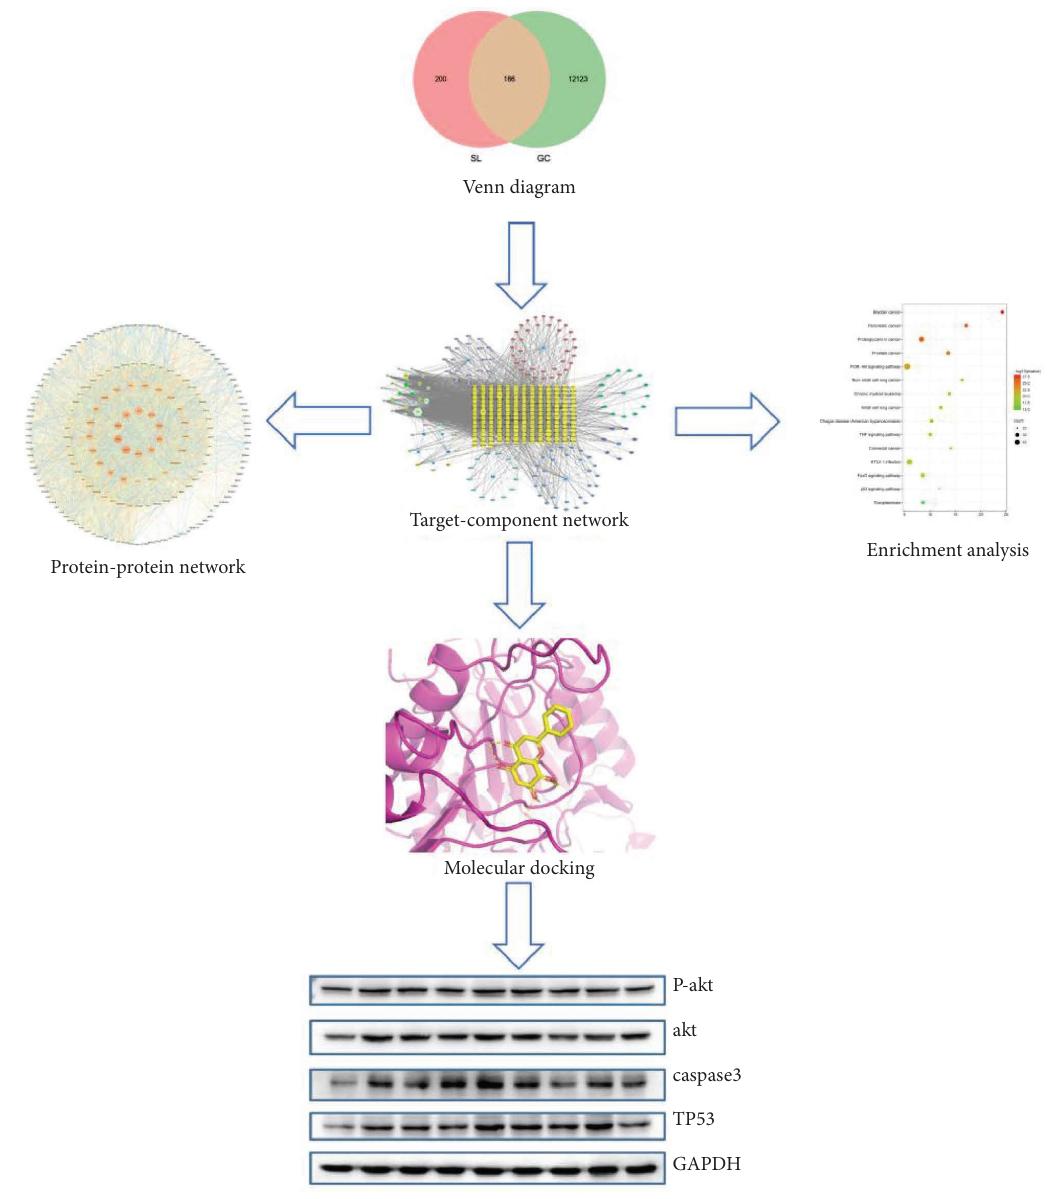
Figure 1: Schematic fow diagram showing the steps used for determining the active ingredients, network pharmacology analysis, molecular docking, and experimental analysis of